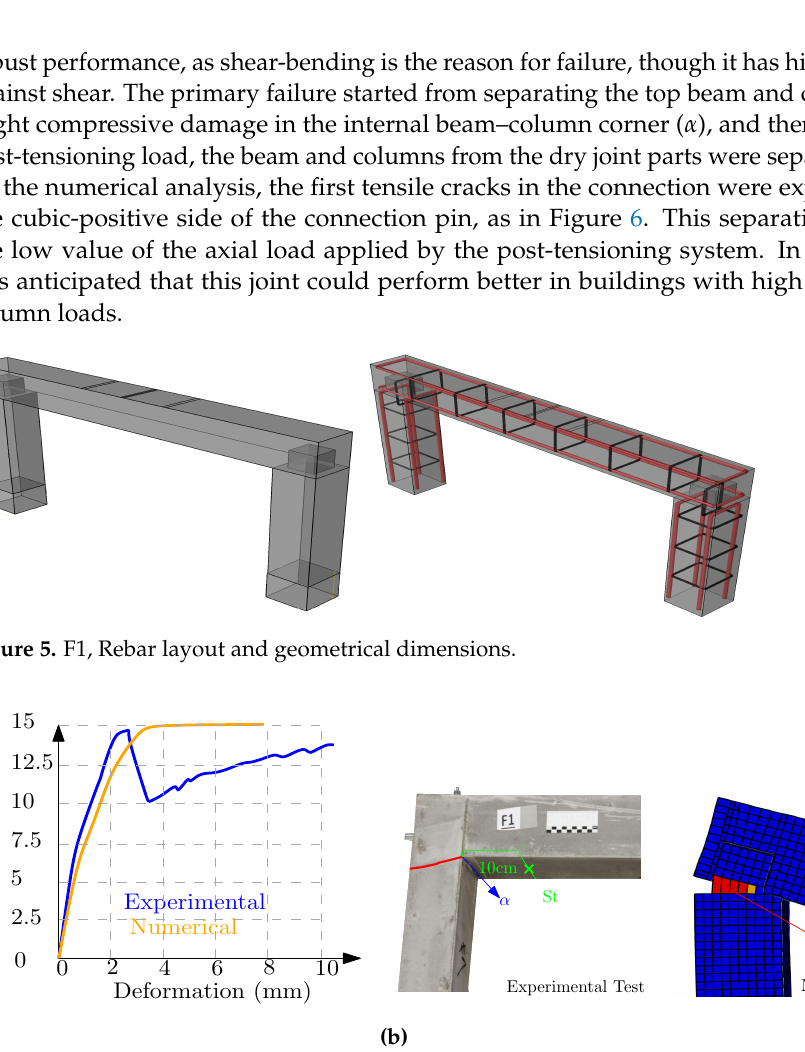
Figure 6. F1, ( a ) Force–deformation, ( b ) experimental cracking and numerical cracking